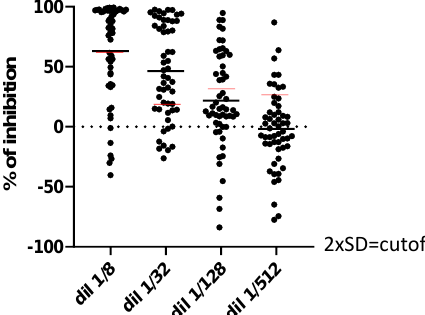
Figure 3. Impact of serum from COVID-19 patients on fusion. Coculture of Hela-S and Hela-ACE2 in 96-well plate for 24 h in the presence of various dilutions of sera (1/8 to 1/512) from COVID-19 patients two weeks after the first symptoms. Each luminescent signal is normalized with the value in the presence of an internal control, made of a pool of seronegative sera. Results are expressed as the percentage of inhibition compared to the internal control serum.